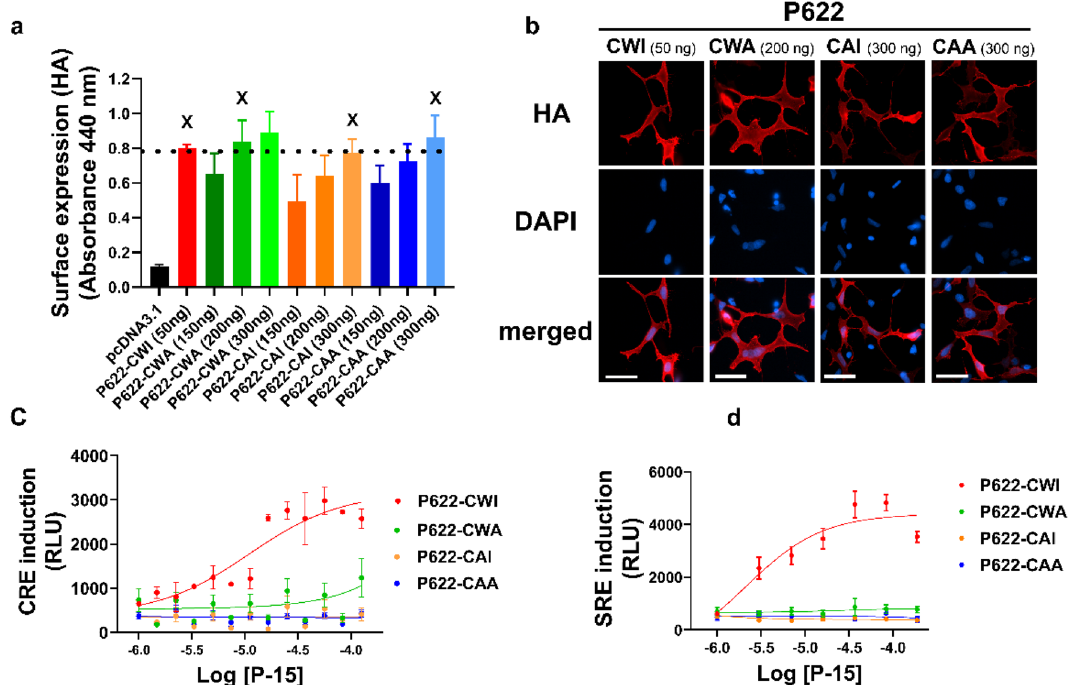
Figure 5. ECL2 plays a major role in ADGRG2 activation by synthetic Stachel peptide. ( a ) HEK cells were transfected with one dose of P622-CWI (50 ng) and different doses of mutant P622 plasmids. Cell surface expression of receptors was determined by ELISA using an antibody against the N-terminal HA-tag in non- permeabilized conditions. X denotes the amount of mutant plasmids that resulted in comparable surface expression as 50 ng P622-CWI plasmid. Data are mean ± S.E.M from a representative experiment out of 3 independent experiments performed in quadruplicate. ( b ) Cell surface expression of receptors, after transfection with the adjusted doses of plasmids, was determined by immunofluorescence imaging using an antibody against the N-terminal HA-tag in non-permeabilized conditions. Nuclear counterstaining with DAPI. Representative images from 3 independent experiments are shown (scale bars: 20 µm). ( c , d ) Cells were transfected with adjusted doses of either P622-CWI or mutant plasmids along with either CRE-Luc ( c ) or SRE-Luc ( d ) plasmids. After an overnight of serum starvation, cells were activated with increasing concentrations of P-15 for 5 h. Luciferase induction was measured in a luminescence-based assay. Relative light units (RLU) recorded in a luminometer are representative from 3 independent experiments performed in triplicate and are presented as mean ±